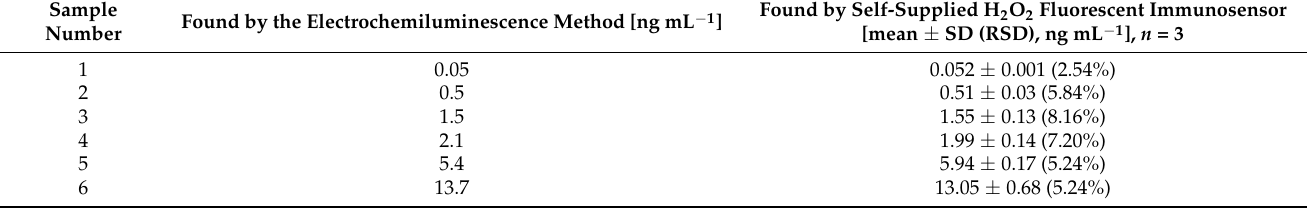
Table 1. Comparison of the results for the determination of CEA in clinical serum samples by using the self-supplied H 2 O 2 fluorescent immunosensor and the referenced electrochemiluminescence